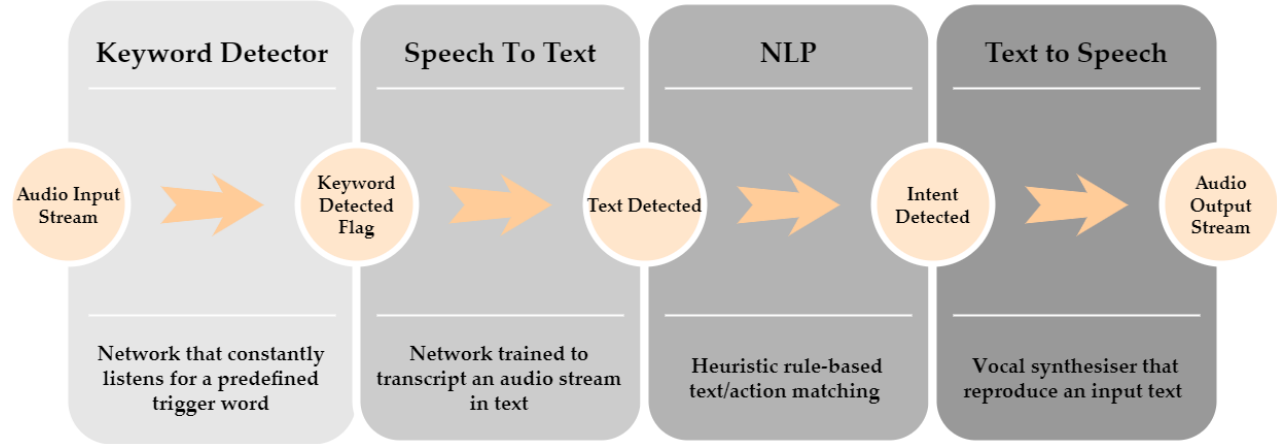
Figure 8. Overview of PIC4Speech vocal assistant architecture. The scheme describes the successive cascade activation of the different components of the vocal assistant